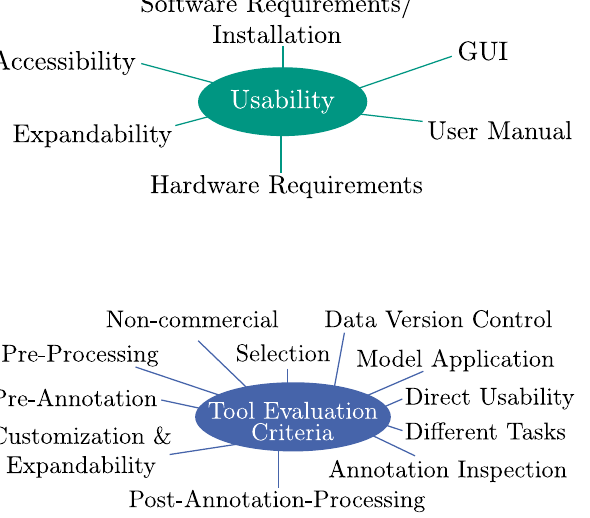
Figure4: Schemeforcomparingannotationtools.Forthe comparison of state-of-the-art image annotation tools, different criteria are used to consider different